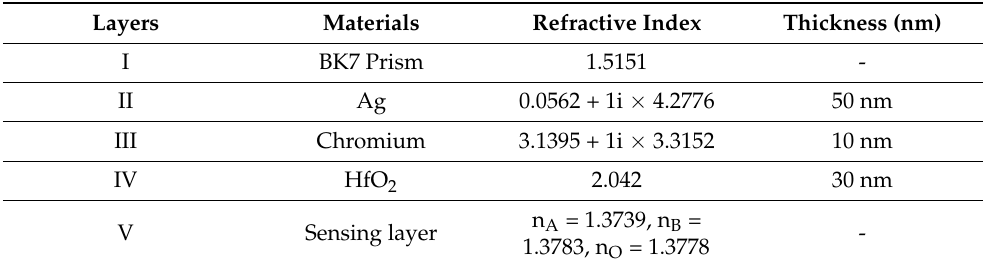
Figure 3. Angle of Incident at a refractive index value of blood groups “A”, “O” and “B”. Table 3. Design parameters of the proposed sensor at 633 shown in Equation (2);